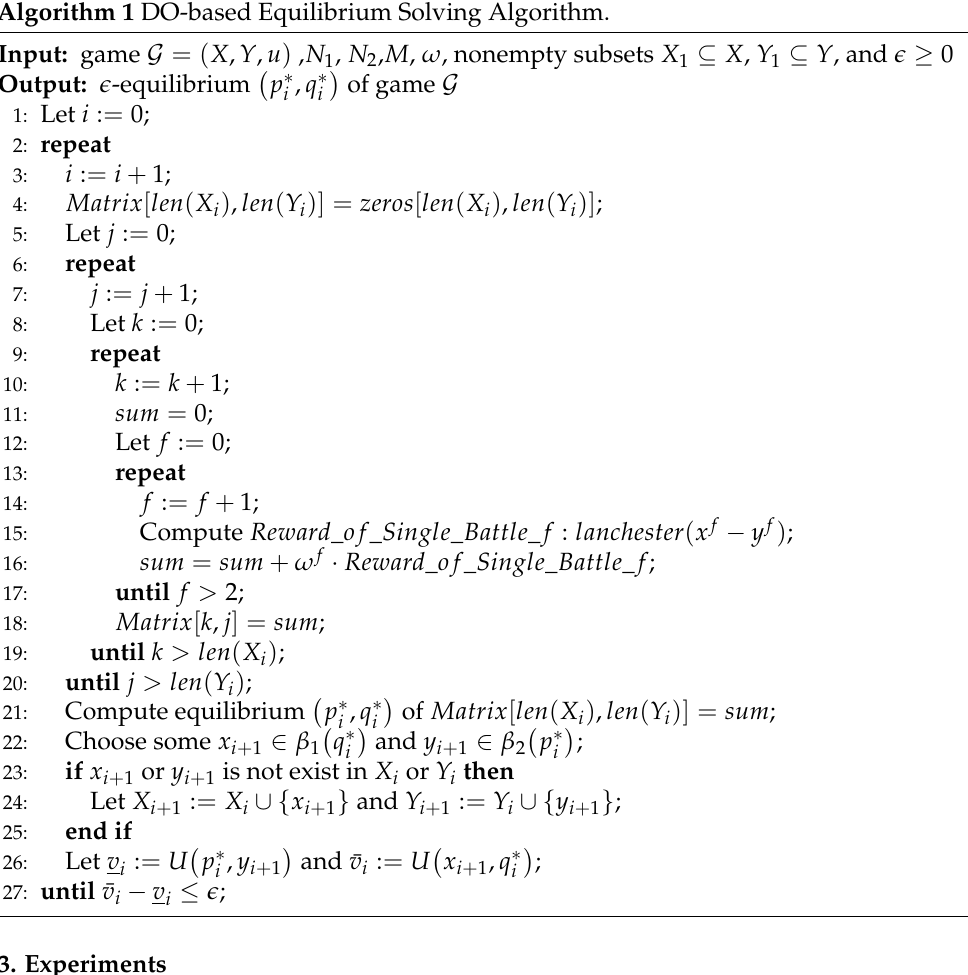
Algorithm 1 DO-based Equilibrium Solving